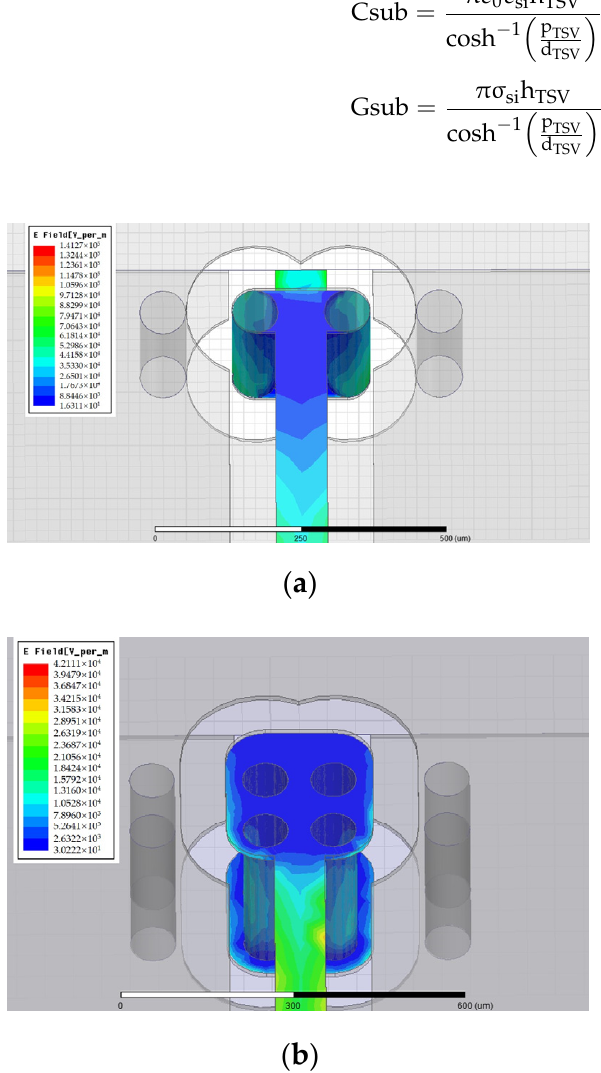
Figure 4. Electric field diagram: ( a ) dual redundant TSV; ( b ) quad redundant TSV.